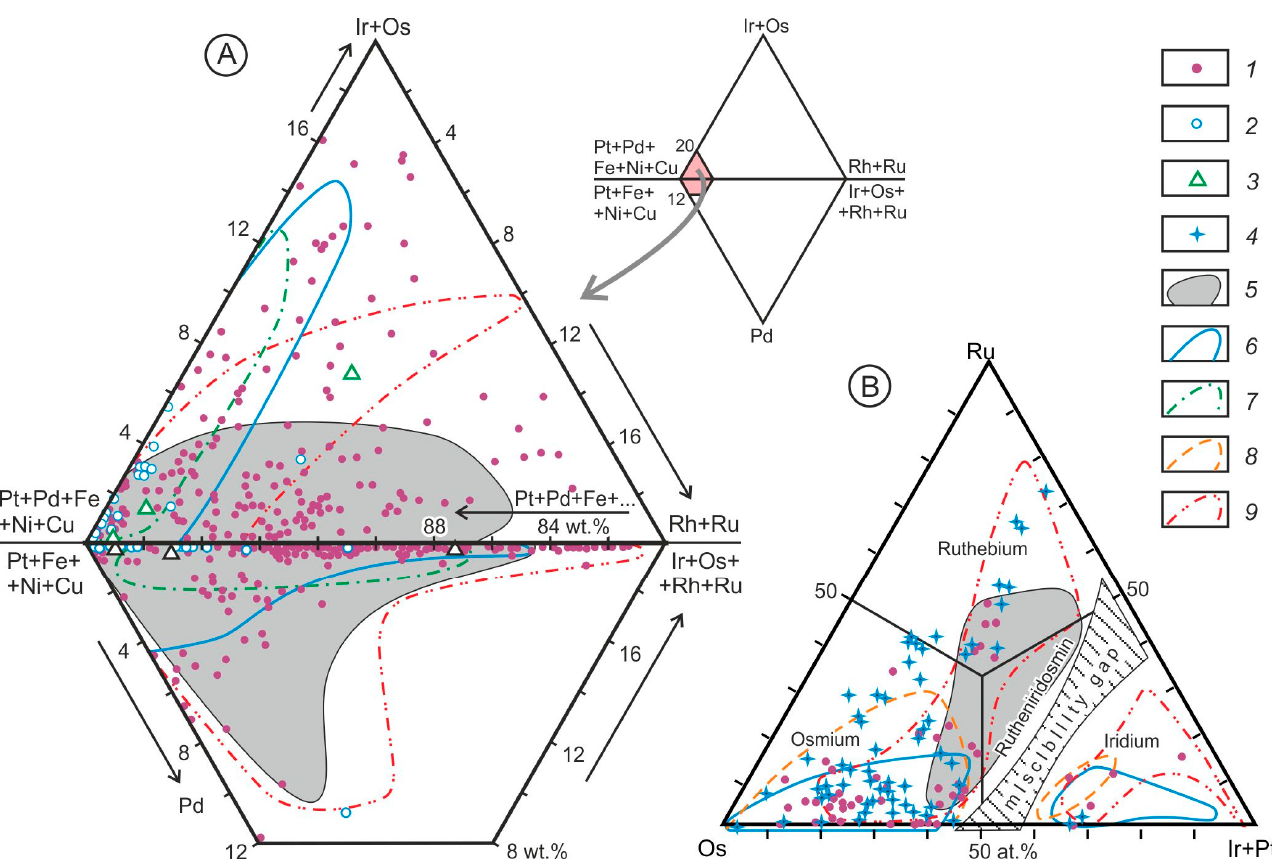
Figure 3. Diagrams of the compositions of Fe–Pt ( A ) and Ru–Ir–Os alloys ( B ). 1—Placers of the Bolshaya, Kuonamka and Anabar rivers [14]; 2—Gulinsky massif [37–40]; 3—placers of the Bor– Uryakh massif [41]; 4—inclusions of Ru–Ir–Os minerals in ferroan platinum from placers of the Anabar river. 5–9—Mineral composition fields from placers of the Vilyui river (5); Inagli massif (6); Ural (7) according to [27], Gulinsky massif (8) according to [37–39] and chromite ores of the Krasnogorsk massif (9) according to [36].